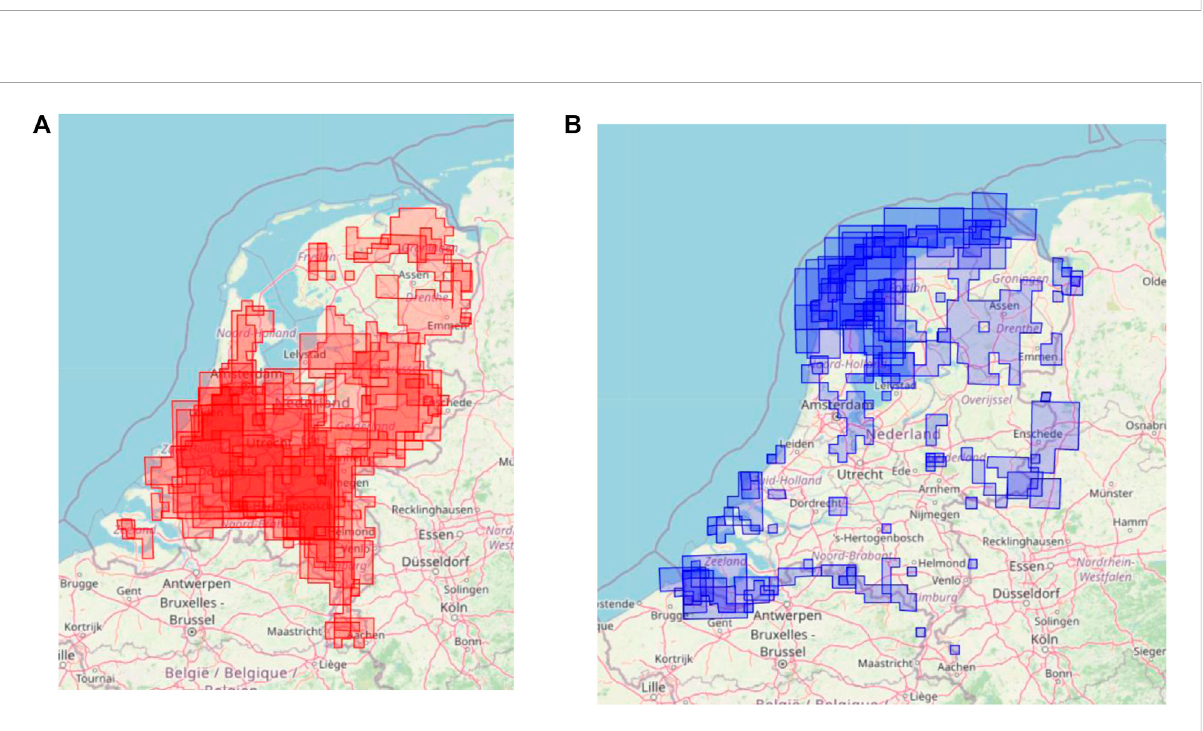
FIGURE 14 (A) Hotspots for all materials in the LMA dataset. Map created by authors. (B) Cold spots for all materials in the LMA dataset. Map created by